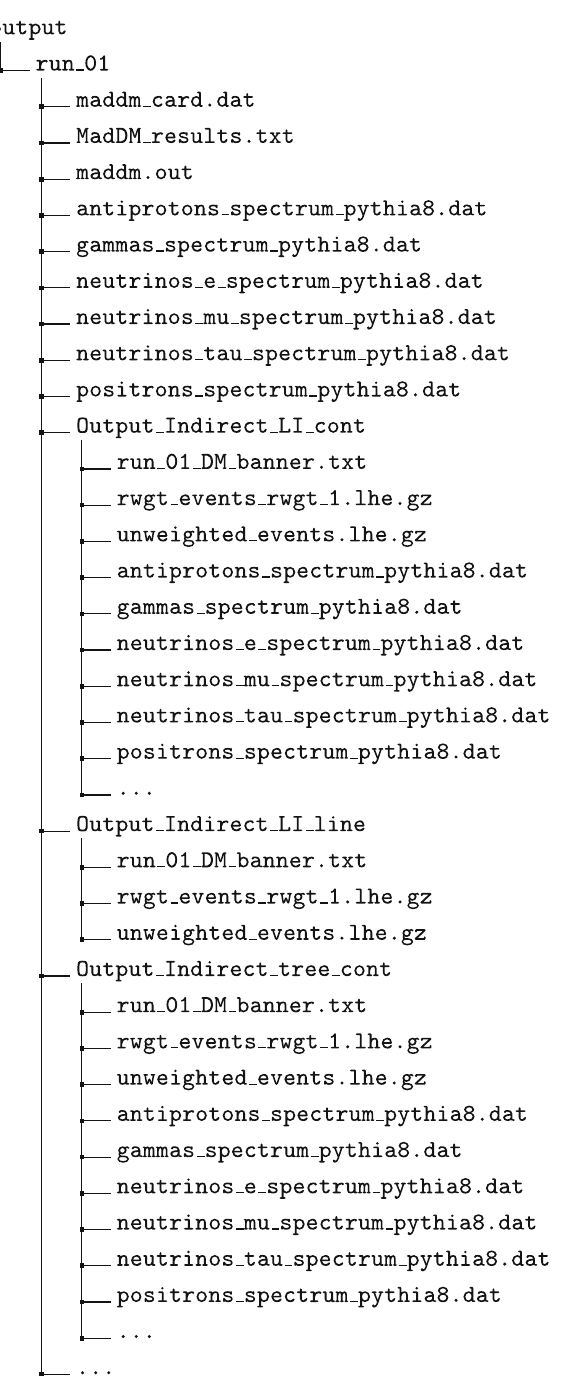
Fig. 6 Example of the indirect detection folders and files of MadDM